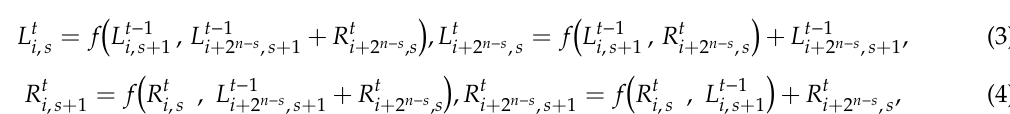
Figure 2. Basic processing element of BP decoder.